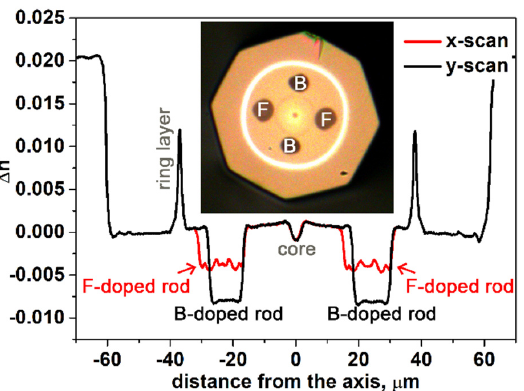
Figure 3. Measured refractive index profile of the realized quasi-BF and photo of the fiber end facet (on the